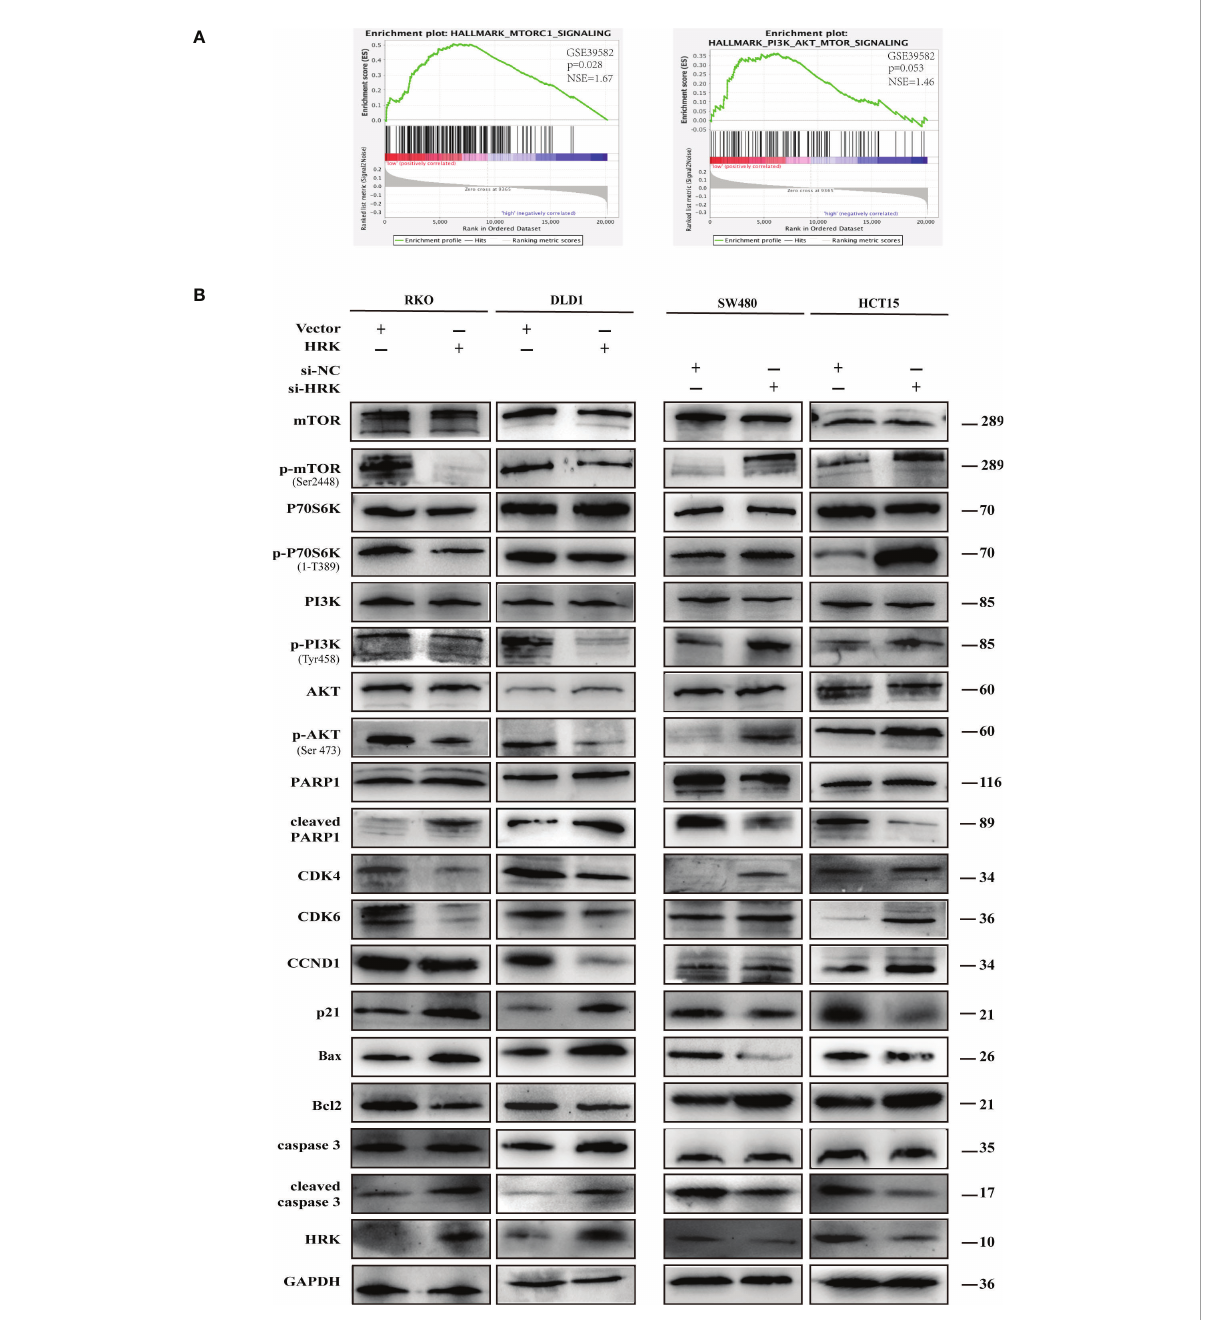
FIGURE 6 HRK regulates CRC processes through PI3K/AKT/mTOR signaling pathway. (A) , GSEA showed the enrichment of mTORC1 and PI3K/AKT/mTOR pathway in CRC cells with HRK downregulation. (B) , Western blotting was performed to detect the leves of mTOR, p-mTOR, PI3K, p-PI3K, P70S6K, p-P70S6K, AKT, p-AKT, PARP1, cleaved PARP1, CDK4, CDK6, Cylin D1, P21, Bax, Bcl-2, caspase3 and cleaved caspase3 in CRC cells that overexpress or downregulate HRK. + represents the use of the material. - means that the material is not